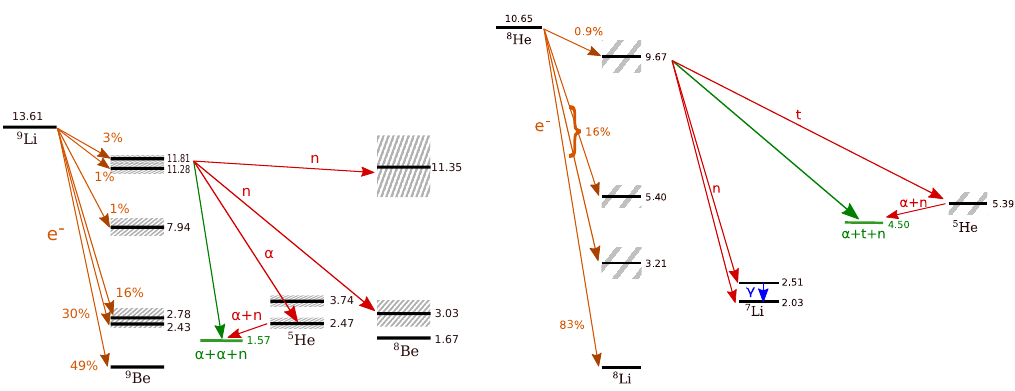
Figure 2 . The decay schemes for 9 Li (left) and 8 He (right), where the energy widths of the states are proportional to the hatched boxes. The (cid:12) -decay branching ratios are indicated along with some of the possible decay paths. The particles released during a transition between levels may be found above the red arrows. The green arrows indicate a direct three-body break-up. In both schemes, the energy levels are in MeV. For 9 Li, the energy levels are quoted in relation to the 9 Be ground state and the (cid:12)nal state for the (cid:12) - n decay path is always (cid:11) + (cid:11) + n . For 8 He, the energy levels are in relation to the 8 Li ground state. Note that the ground state of 7 Li is